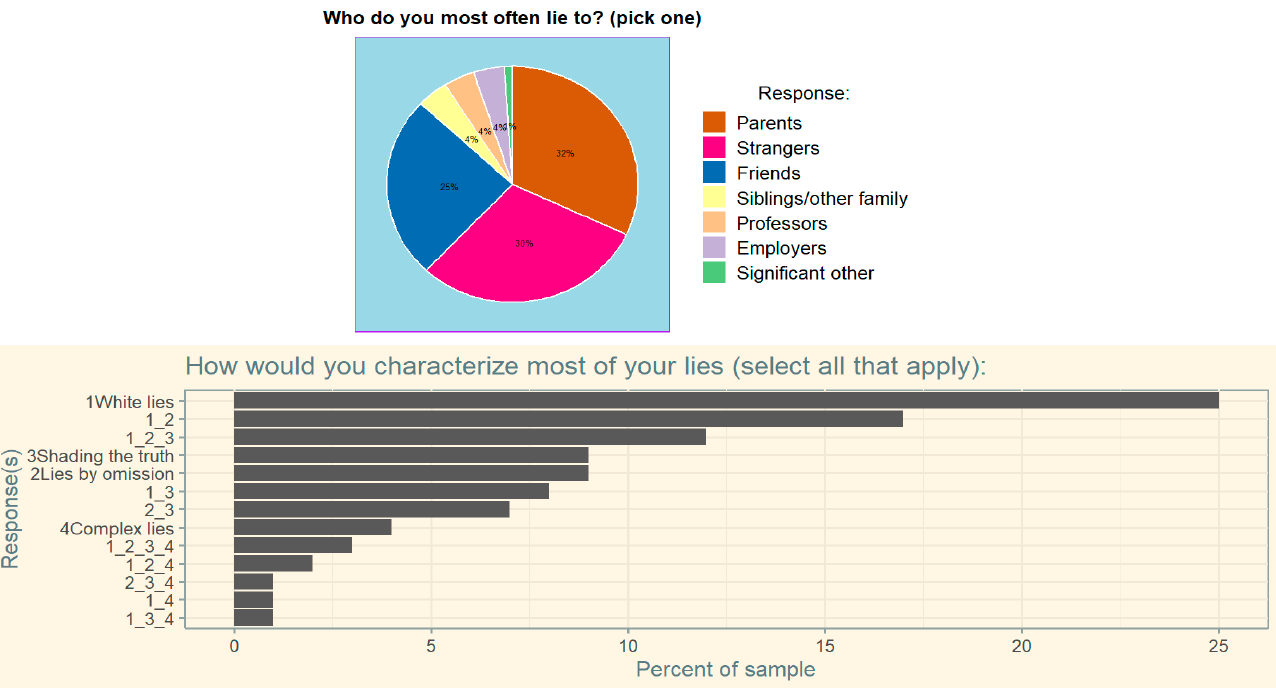
Figure 1. Who did our study sample most often lie to and how did they characterize their lies? The complete response options to the question “How would you characterize most of your lies? (select all that apply)” were as follows: 1. White lies (harmless or trivial lies); 2. Lies by omission (leaving out the truth); 3. Shading the truth (leaving out or concealing part of the truth); 4. Complex lies (relating to your identity, accomplishment, or merit). 1_2 White lies (harmless or trivial lies); Lies by omission (leaving out the truth). 1_3: White lies (harmless or trivial lies); Shading the truth (Leaving out or concealing part of the truth) 1_4: White lies (harmless or trivial lies); Complex lies (relating to your identity, accomplishment, or merit). 2_3: Lies by omission (leaving out the truth); Shading the truth (leaving out or concealing part of the truth). 1_2_3: White lies (harmless or trivial lies); Lies by omission (leaving out the truth); Shading the truth (leaving out or concealing part of the truth). 1_2_4: White lies (harmless or trivial lies); Lies by omission (leaving out the truth); Complex lies (relating to your identity, accomplishment, or merit). 1_3_4: White lies (harmless or trivial lies); Shading the truth (Leaving out or concealing part of the truth); Complex lies (relating to your identity, accomplishment, or merit). 2_3_4: Lies by omission (leaving out the truth); Shading the truth (leaving out or